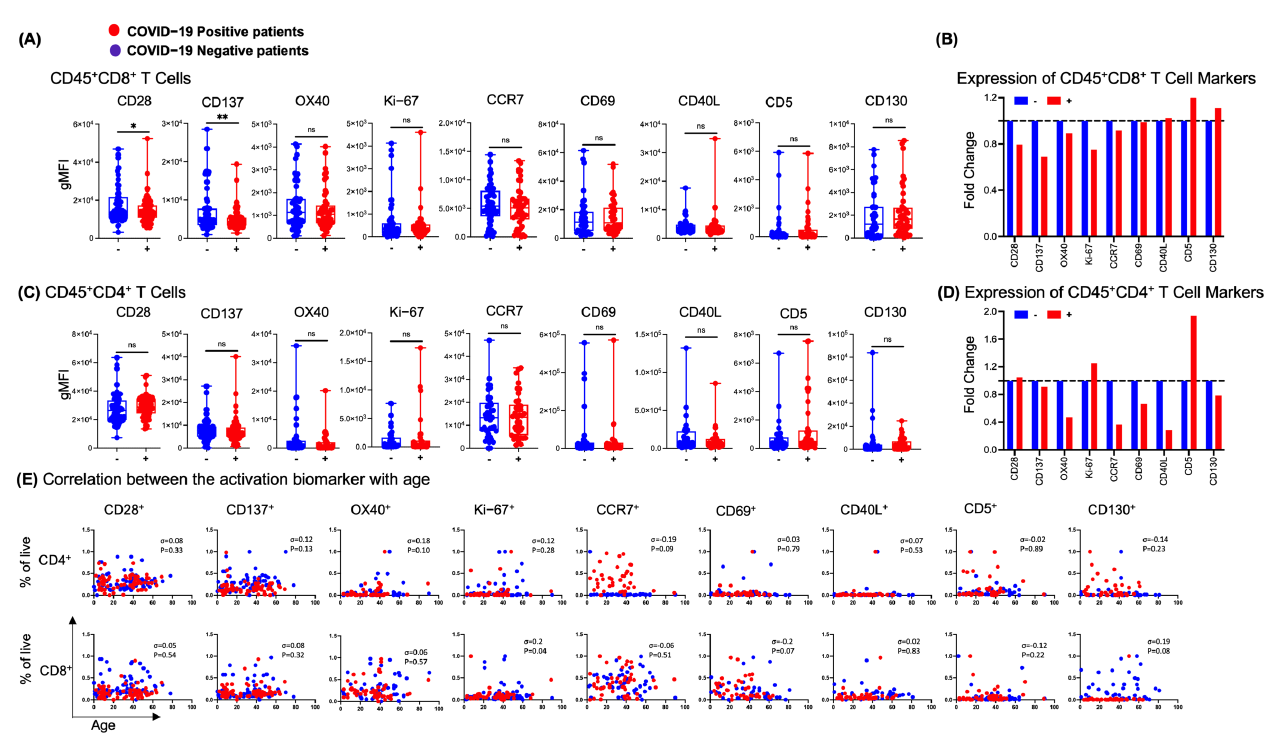
Figure 5. SARS-CoV-2 infection is associated with a decreased expression of CD28 and CD137 on CD8 + T-cells in nasal swab samples. Activation phenotypes of nasopharyngeal T-cell subset, ( A ) CD8 + T-cells, and ( B ) the fold-change of activation markers on CD8 + T-cells. ( C ) Activation phe- notypes of CD4 + T-cells and ( D ) the fold-change of activation markers on CD4 + T-cells. ( E ) Spearman correlations between the activation markers on CD4 + and CD8 + T-cells with the age of COVID-19- positive and -negative patients. (Activation markers, CD5, CCR7, Ki67 and OX40 were studied in COVID-19-positive (N = 38) and -negative (N = 45) patients); (Activation markers, CD130, CD40L, and CD69, were studied in COVID-19-positive (N = 32) and -negative (N = 33) patients) and (Activa- tion markers, CD137 and CD28 were studied in COVID-19-positive (N = 46) and -negative (N = 55) patients). Each dot represents an individual. * denotes p ≤ 0.05, ** denotes p ≤